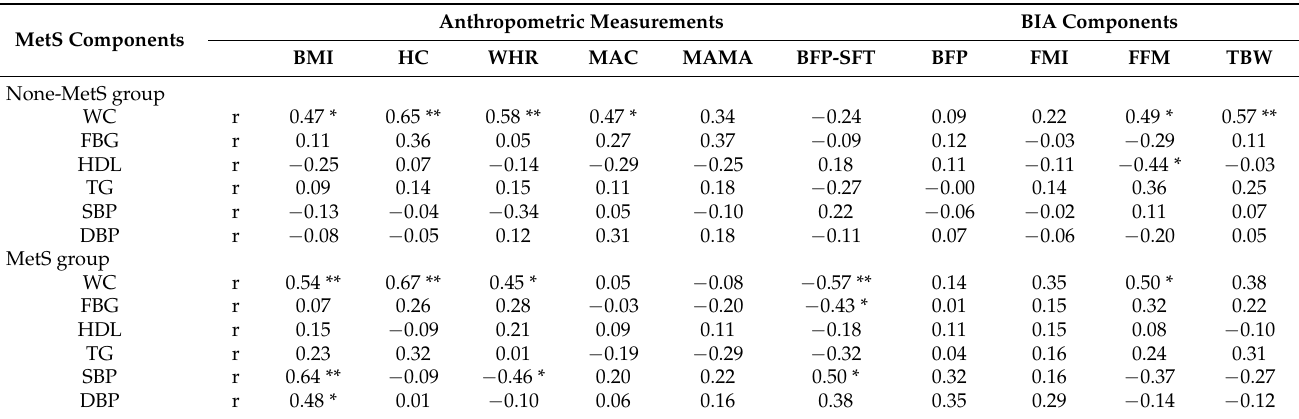
Table 2. Correlation of anthropometric measurements and BIA components with the components of MetS in the None-MetS and MetS groups.